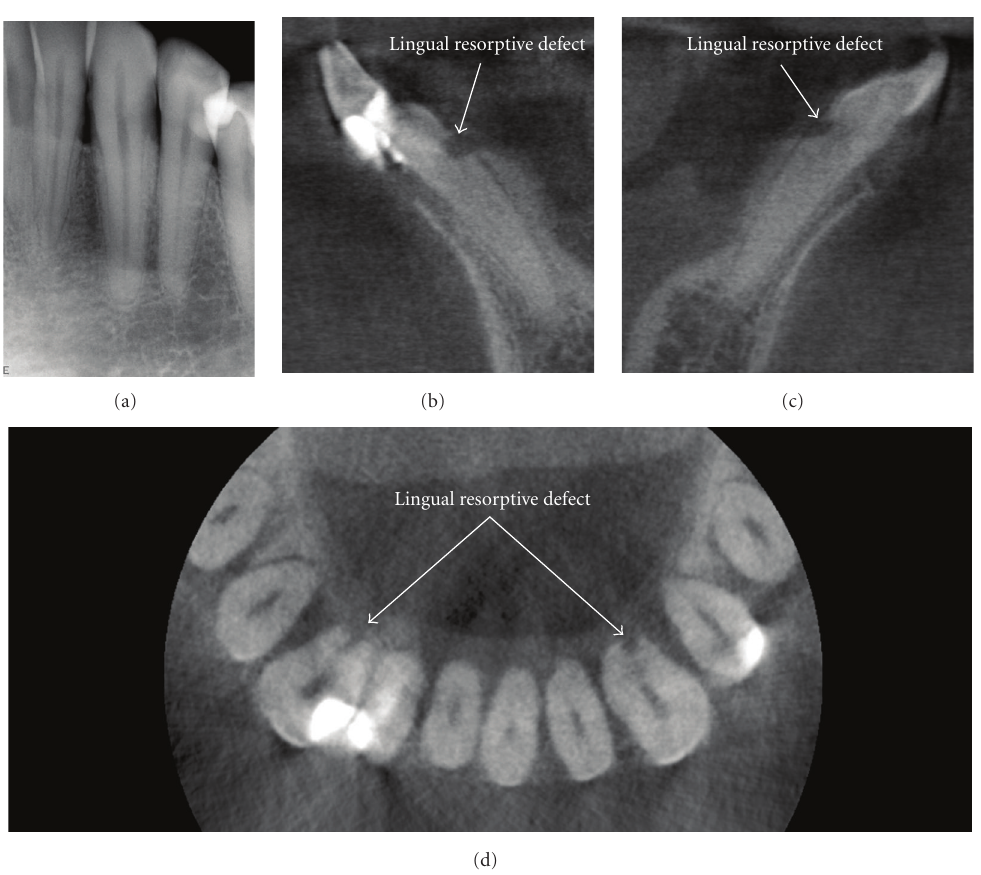
Figure 14: This patient was referred for endodontic revision of the mandibular right lateral incisor. Initial periapical radiographic examination of the mandibular anterior teeth including the left anterior (a) was unremarkable. Note the appearance of a large radiolucency at the on the distal surface of the left canine due to nonperpendicular X-ray beam projection of the distal curvature of the cervical margin. CBCT images ((b) right cross-sectional, (c) left cross-sectional, (d) axial) demonstrated an occult finding of early ERR on the mandibular left and right mandibular cuspids. Early detection and classification of the lesion improve the prognosis and assist in early direct treatment consisting of surgical exposure and removal of granulation tissue from the resorbing lacunae and